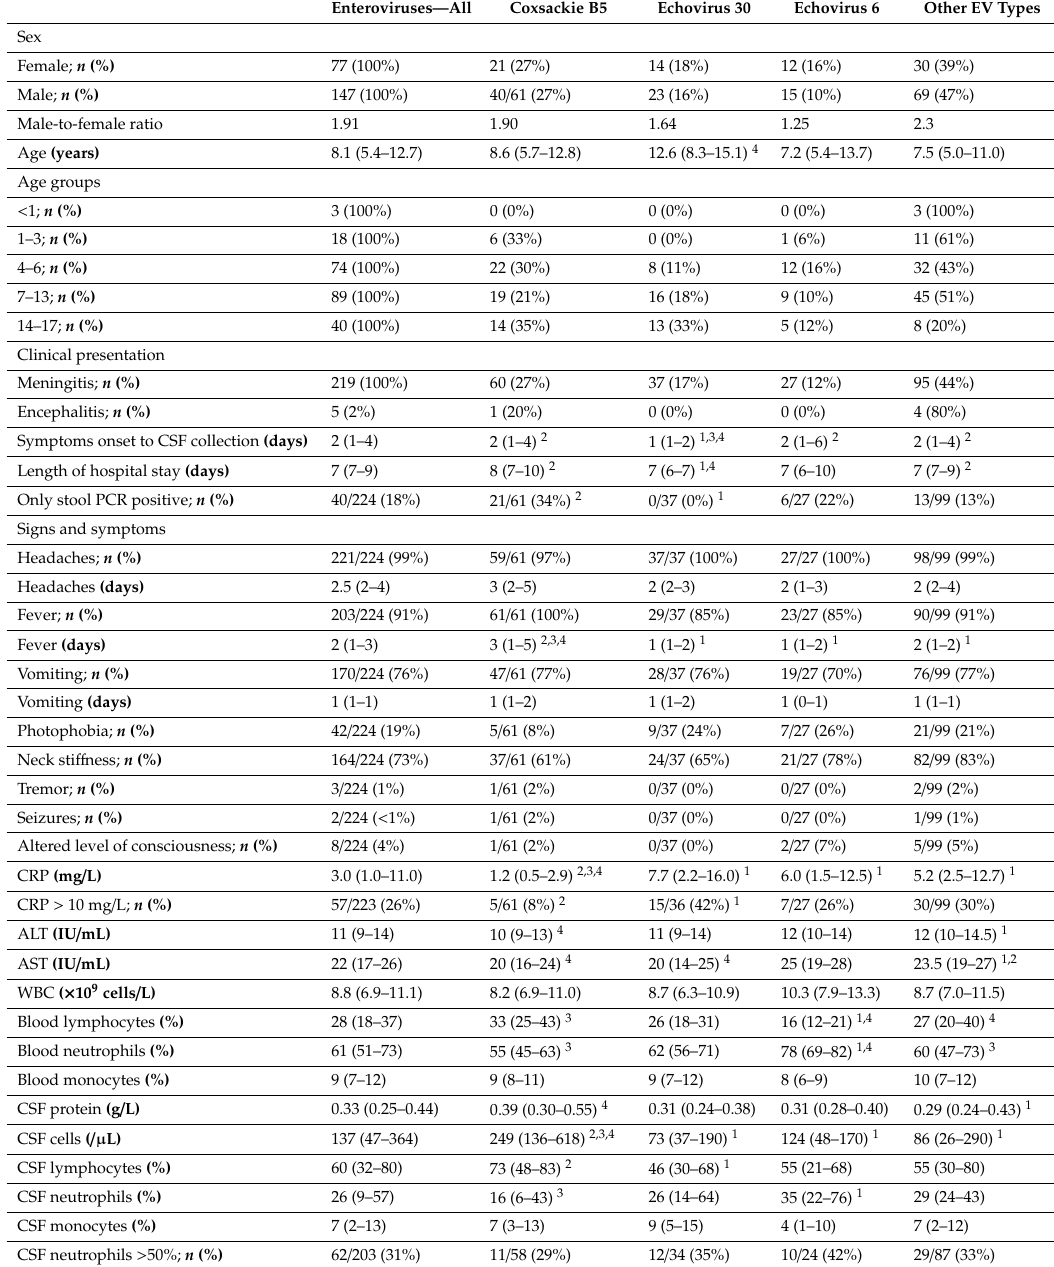
Table 2. Clinical features of the study population by type of